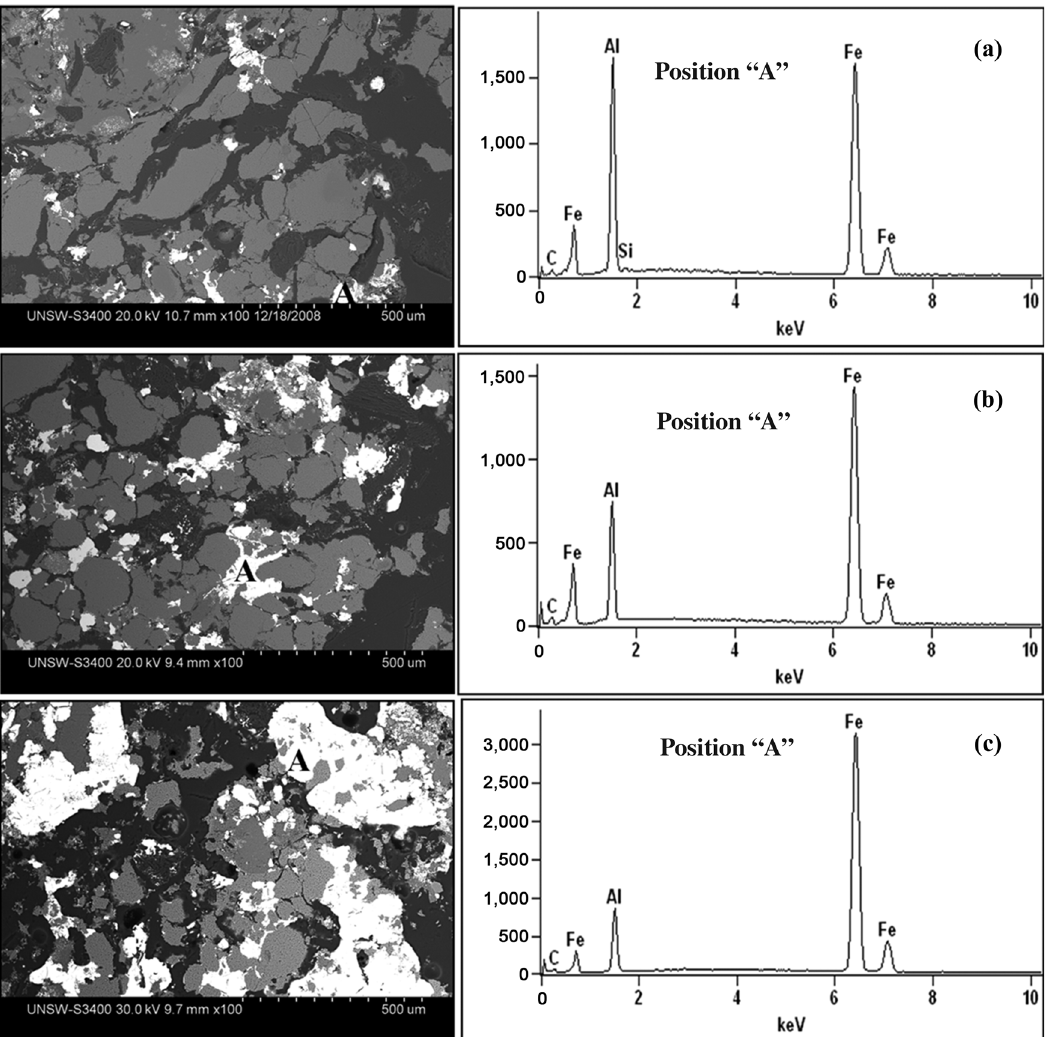
Figure 5: Microstructure and EDS analysis of (a) AS1 – 5Fe, (b) AS1 – 10Fe and (c) AS1 – 15 Fe pellets after heat treatment. Alumina (gray region), carbon (dark region) and Fe – Al reaction product (white region) can be seen clearly in these